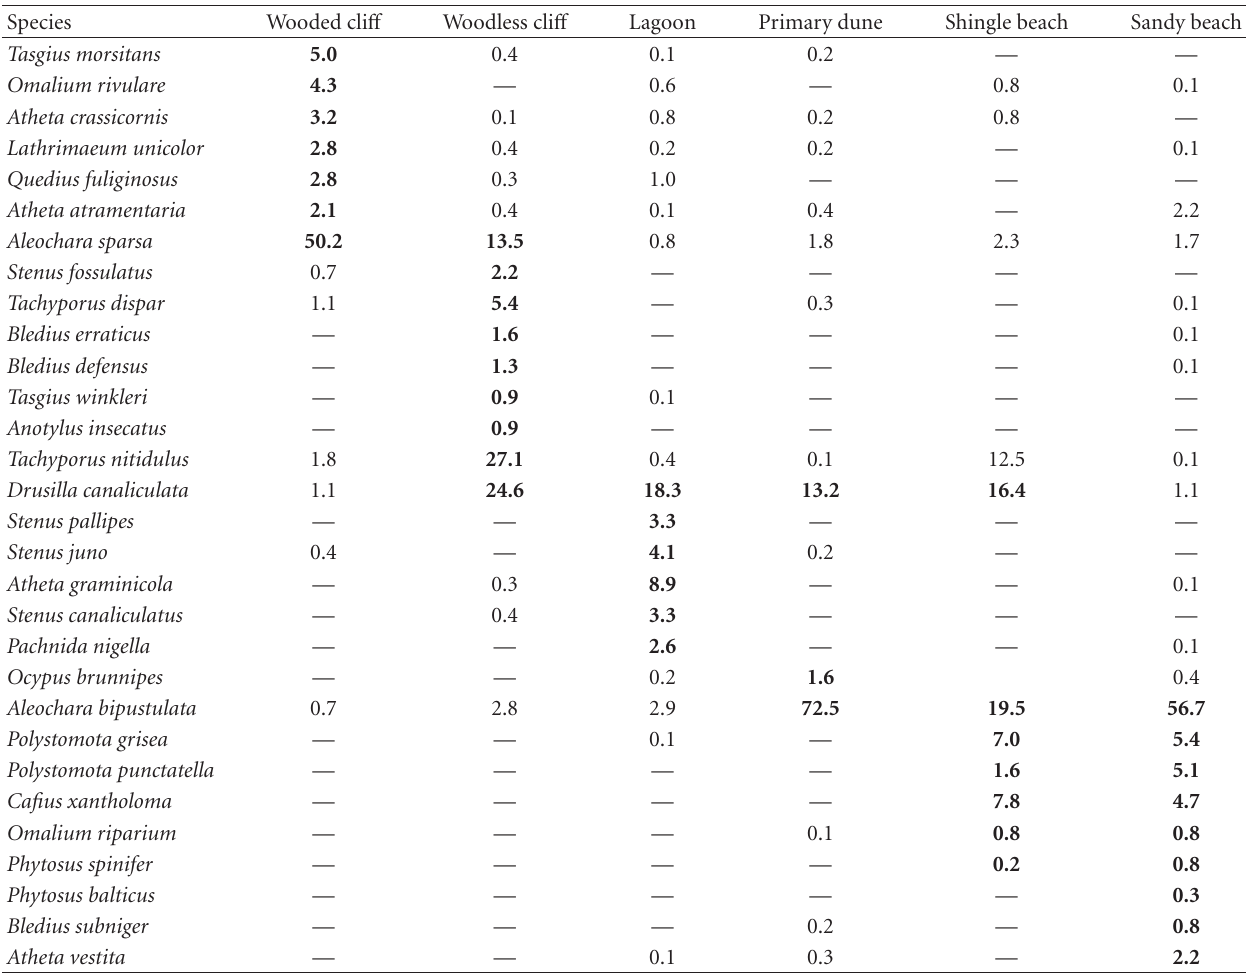
Table 4: Dominance of species that contribute to the species characterisation of the habitats. Species